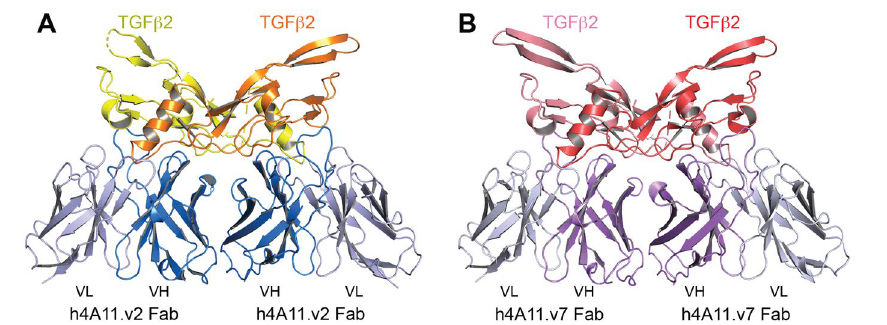
Figure 2. The structures of h4A11.v2 and h4A11.v7 Fabs in complex with TGFβ2 are similar. Overall structures of ( A ) TGFβ2-dimer:h4A11-v2 Fab complex and ( B ) TGFβ2-dimer:h4A11-v7 Fab complex are very similar with RMSD of 1.04 Å for all atoms (only VH-VL regions in the Fab are shown for